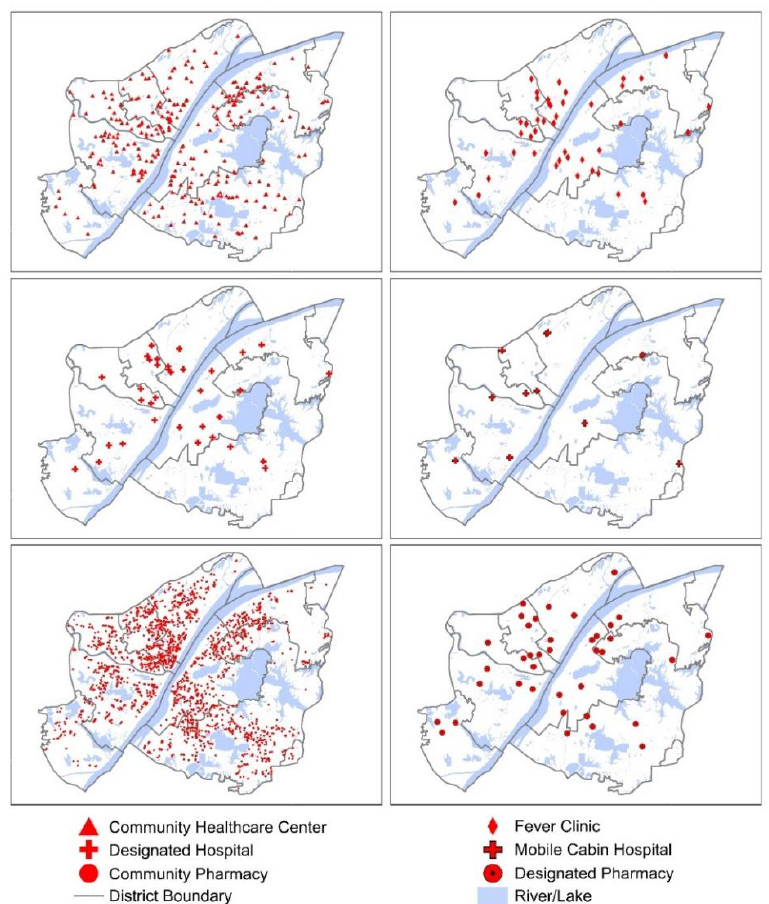
Figure 1. Population of communities (2010) and districts in the urban area of Wuhan [40].